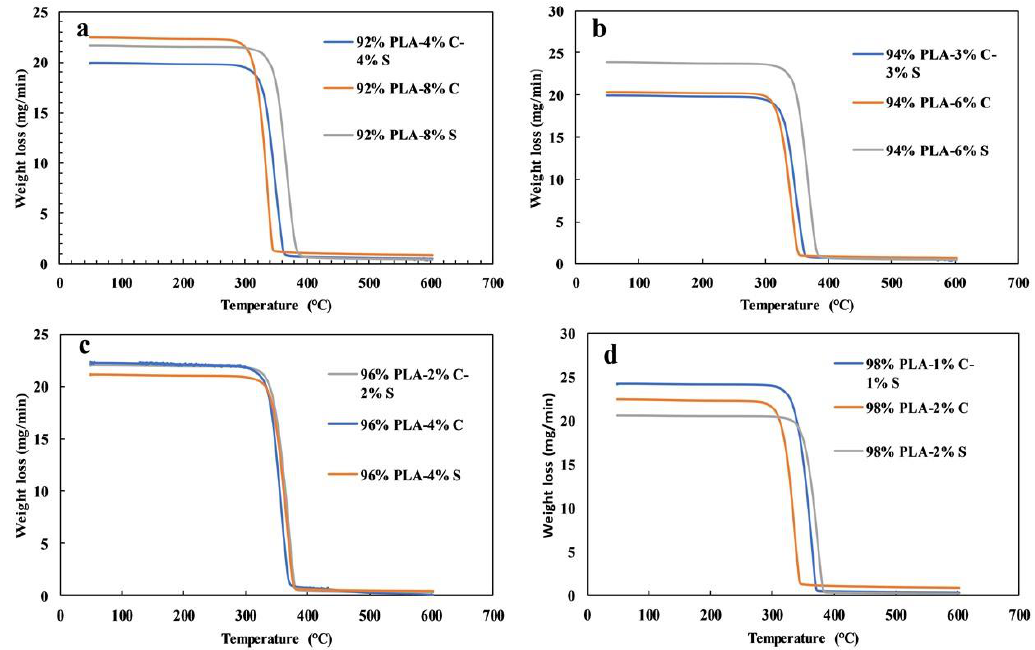
Figure 6. Thermogravimetry analysis for ( a ) 92%, ( b ) 94%, ( c ) 96% and ( d ) 98% PLA sets of samples.